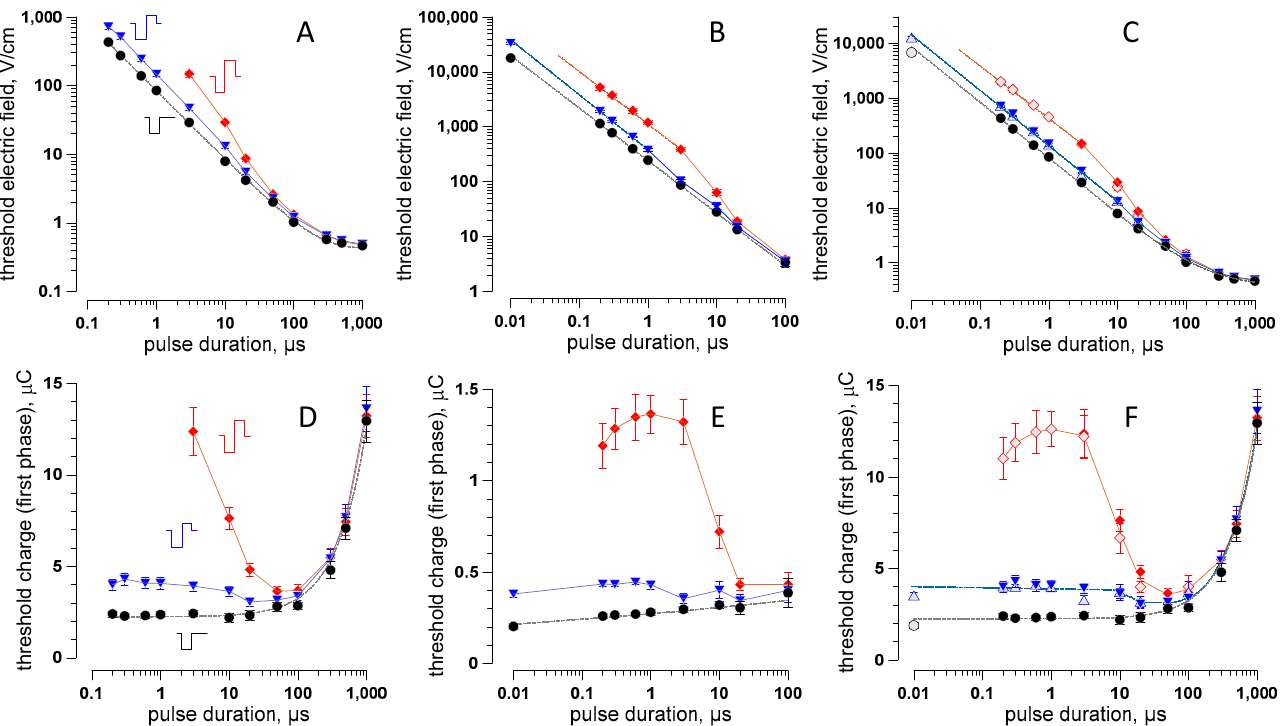
Figure 2. Strength–duration curves ( A – C ) and the respective electric charge thresholds ( D – F ) for unipolar cathodic pulses and bipolar pulses with the 2nd (anodic) phase 50% or 100% of the 1st (cathodic) phase. Electrodes were placed perpendicular to the nerve at a 5-mm distance to the cathode ( A , D ) or with the cathode touching the nerve ( B , E ). Panels ( C , F ) combine the thresholds measured at 5 mm (solid symbols) and those extrapolated from 0 mm to 5 mm (open symbols; see text for details). Dashed lines are data fits using the Lapicque formulation ( A , D ) or power function ( B – F ); solid lines just connect the mean values. Mean ± SE, n = 8–14 for most datapoints. Error bars may be not visible when they are smaller than the central symbol.